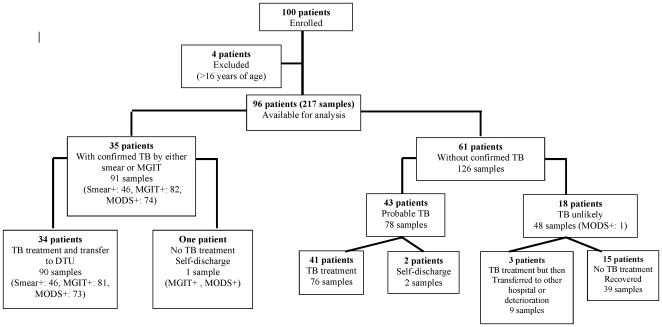
Patient recruitment and assignment of patients to ‘confirmed’, ‘probable’, or ‘TB unlikely’ groups.